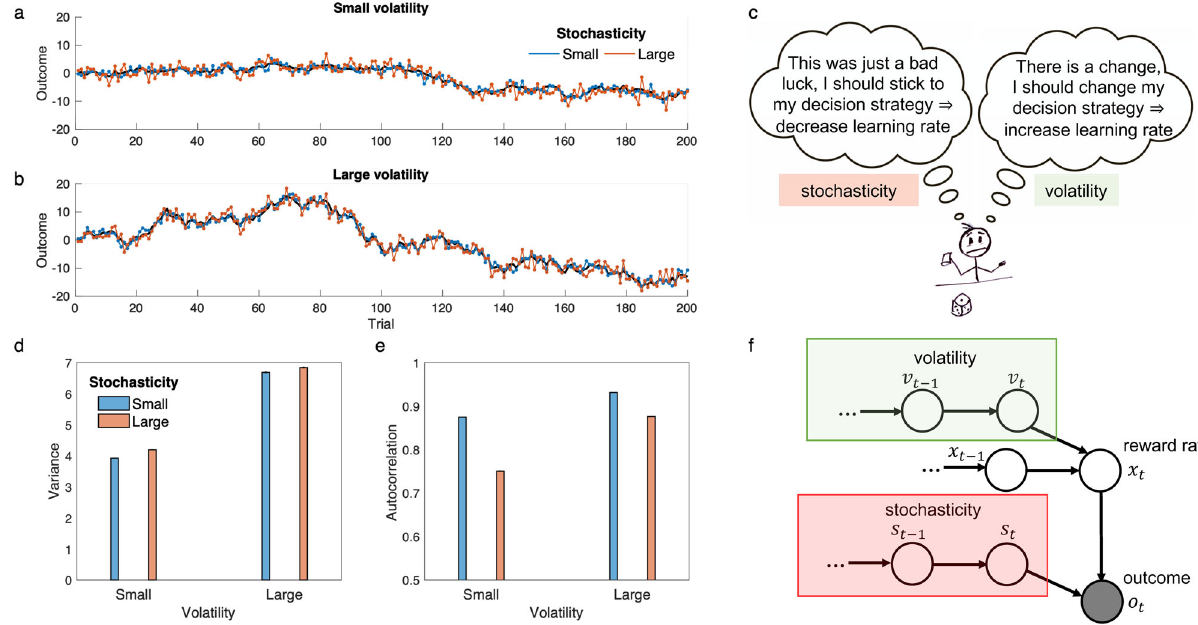
Fig. 1 Statistical difference between volatility and stochasticity. a – b Examples of generated time-series based on a small and large constant volatility parameter given a small ( a ) or a large ( b ) constant stochasticity parameter are plotted. c Given a surprising observation (e.g., a negative outcome), one should compute how likely the outcome is due to the stochasticity (left balloon) or due to the volatility (right balloon). Dissociating these two terms is important for learning, because they have opposite in fl uences on learning rate. d – e It is possible to infer both volatility and stochasticity based on observed outcomes, because these parameters have dissociable statistical signatures. In particular, although both of them increase variance ( d ), but they have opposite effects on autocorrelation ( e ). In particular, whereas volatility increases autocorrelation, stochasticity tends to reduce it. Here, 1-step autocorrelation (i.e., correlation between trial t and t (cid:2) 1) was computed for 100 time-series generated with parameters de fi ned in b and c . Small and large parameters for volatility were 0.5 and 1.5 and for stochasticity were 1 and 3, respectively. f Structure of the (generative) model: outcomes were stochastically generated based on a probabilistic model depending on reward rate, stochasticity and volatility. Only outcomes were observable (the gray circle), and value of all other parameters should be inferred based on outcomes. The observed outcome is given by the true reward rate, x t , plus some noise whose variance is given by the stochasticity, s t . The reward rate itself depends on its value on the previous trial plus some noise whose variance is given by the volatility, v t . Both volatility and stochasticity are dynamic and probabilistic Markovian variables generated noisily based on their value on the previous trial. Thus, the model has two modules, volatility and stochasticity, which compete to explain experienced noise in outcomes. See Methods for formal treatment of the model. Errorbars in ( d – e ) are standard error of the mean calculated across 10000 simulations and are too small to be visible. Source data are provided as Source Data fi trial to trial (modeled as Gaussian diffusion); stochasticity describes additional measurement noise in the observation of each outcome around its true value (modeled as Gaussian noise on each trial).